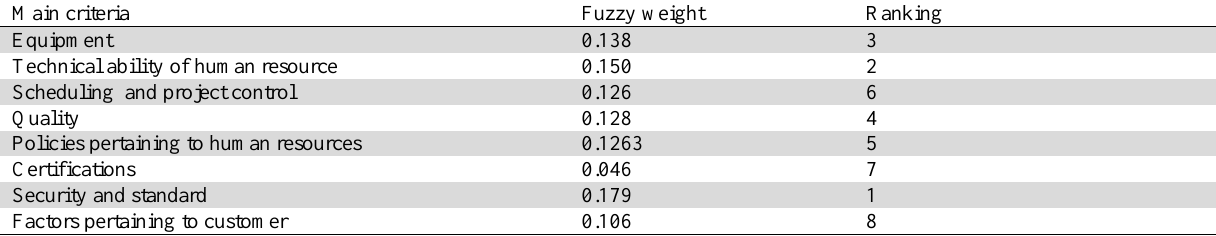
Weighting and ranking main criteria using